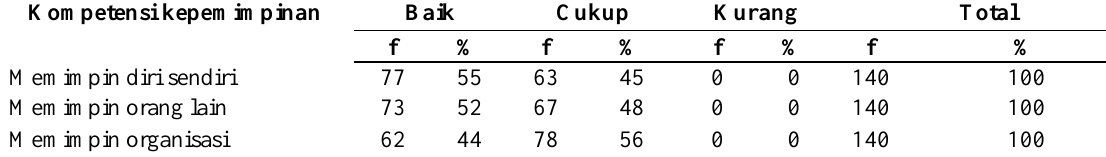
Tabel 3. Distribusi frekuensi kompetensi kepemimpinan kepala ruang Kompetensi kepemimpinan